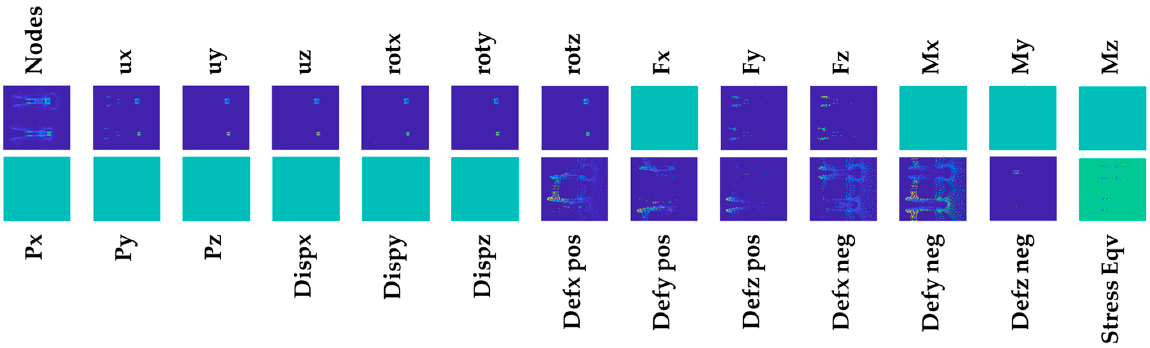
Figure 8. Example of the resulting matrices for one inliner frame